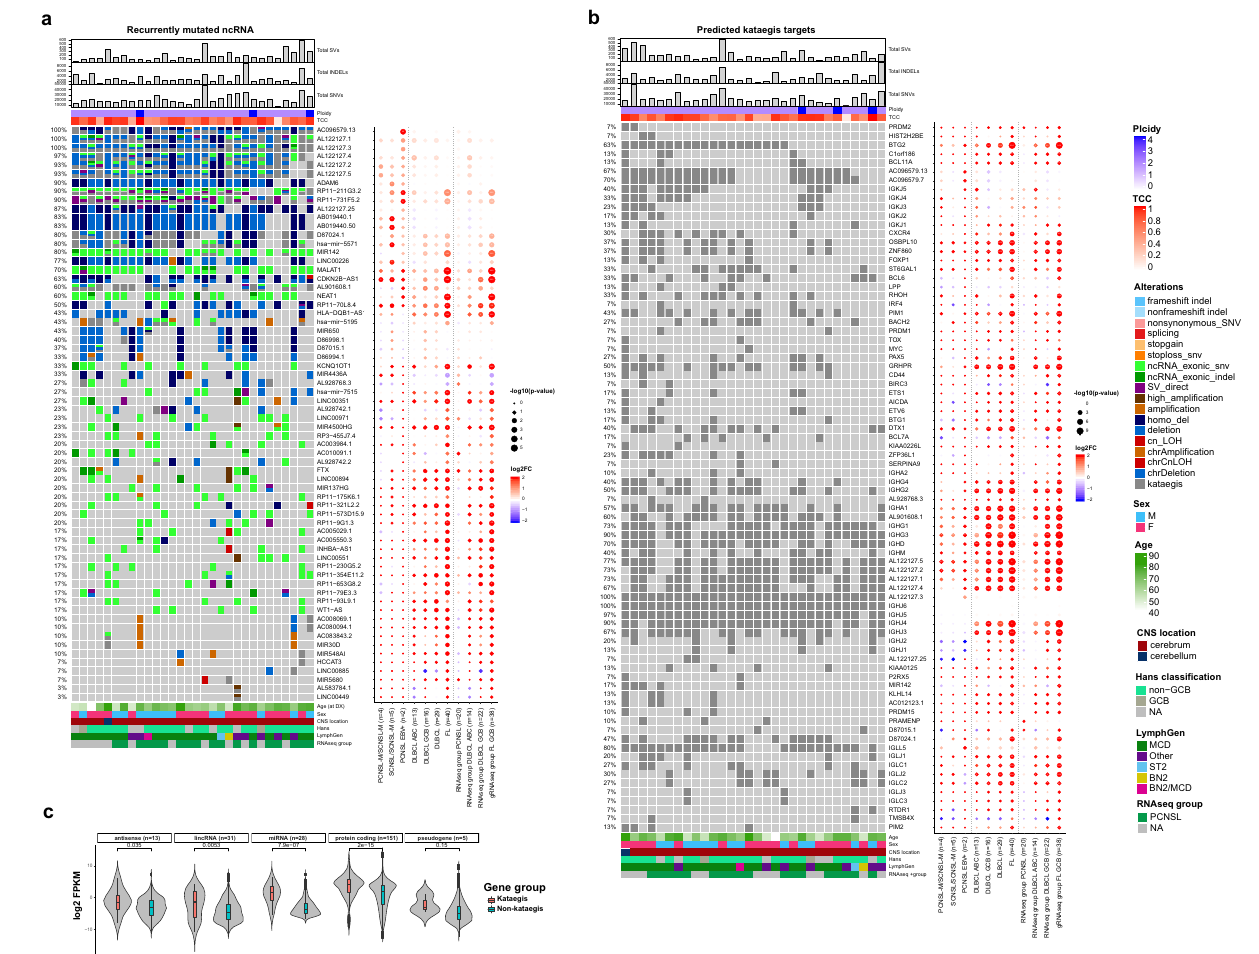
Fig. 3 Recurrent non-coding RNA mutations and Kataegis events in PCNSL. Oncoprint of recurrent non-protein-coding genes in PCNSL ( a ). Shown are the total numbers of structural variants (SVs), small insertions/deletions (INDELs), single nucleotide variants (SNVs), estimated ploidy, and tumor cell content (TCC) (top panel). Mutated genes are listed from top to bottom depending on their alteration frequency. Oncoprint of recurrent kataegis events in PCNSL ( b ). Mutated genes are listed from top to bottom depending on chromosome location. The corresponding dot plot re fl ects the log2 fold change and signi fi cance of alteration frequencies in the other subcohorts and RNAseq subgroups compared to PCNSL. In panels a and b the size of the dots demonstrate the signi fi cance according to a two-tailed Fisher ’ s exact test not corrected for multiple testing. The violin plot c shows that the RNA expression of genes with kataegis loci compared to those without were signi fi cantly higher for antisense, long non-coding RNA, miRNA and protein coding genes (one-sided Wilcoxon rank sum test, p < 0.05). Box and whisker plots are embedded in the violin plots, showing median (center line), the upper and lower quartiles (the box), and the range of the data (the whiskers), excluding